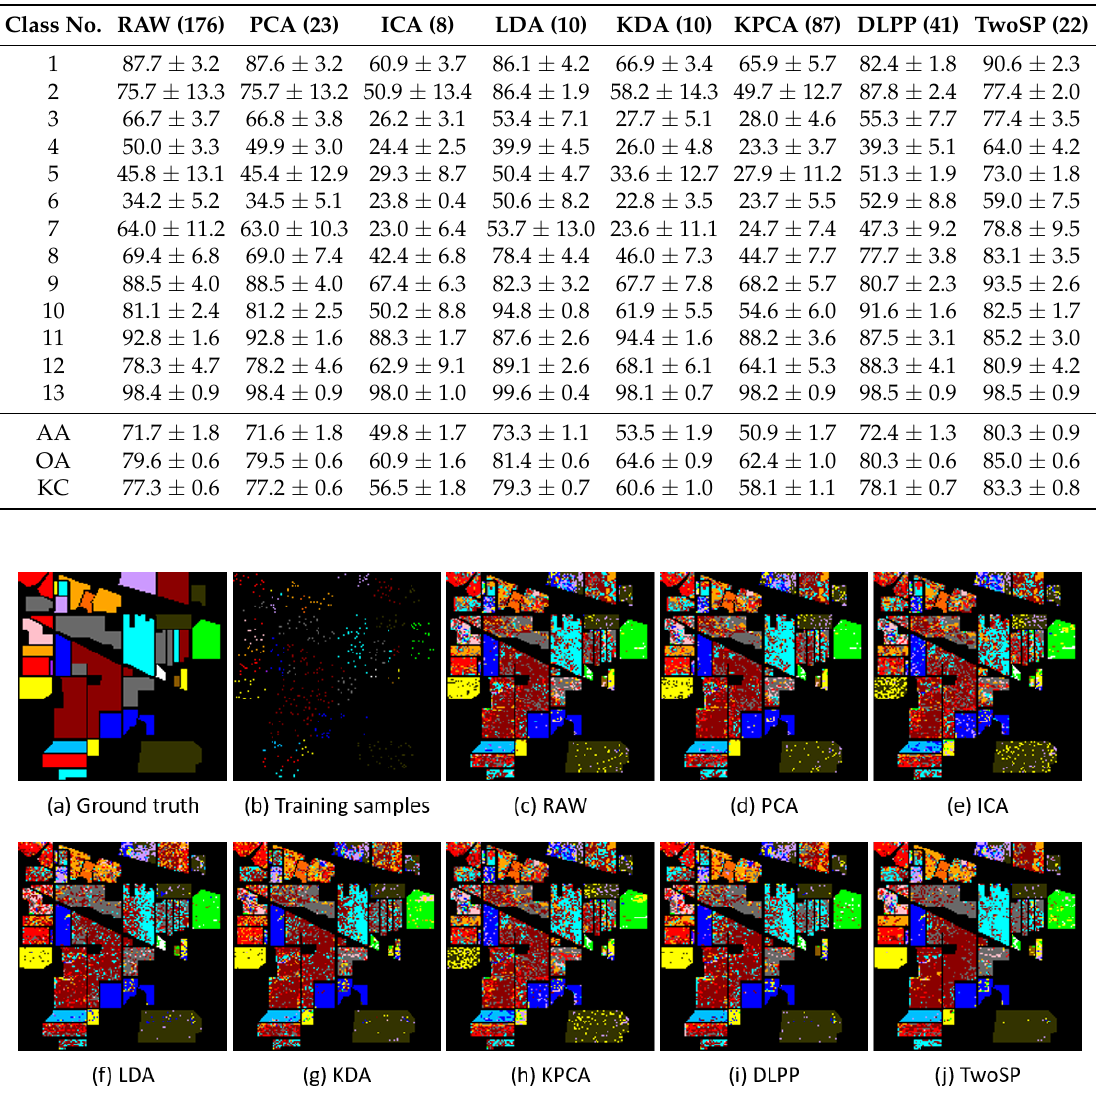
Figure 1. Classification maps for the Indian Pines dataset with different dimensionality reduction algorithms using NN classifier. ( a ) The ground truth of the classes. ( b ) Randomly selected training samples. ( c ) Result obtained by using RAW features. ( d ) PCA. ( e ) ICA. ( f ) LDA. ( h ) KDA. ( g ) KPCA. ( i ) the proposed DLPP. ( j ) The proposed